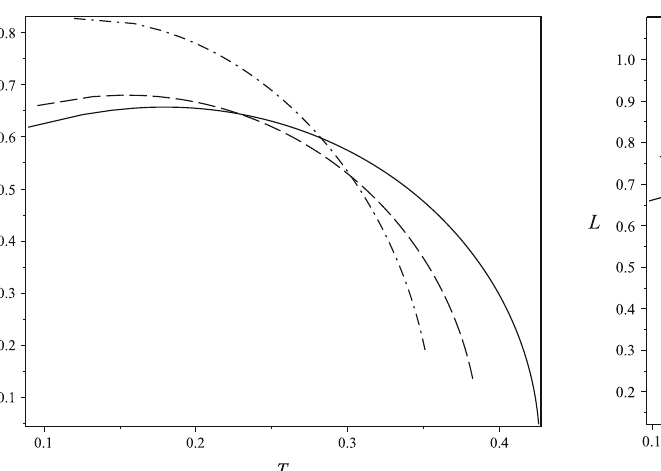
graph demonstrates the L – T dependence for fixed α = 0 . 3 and several values of n , namely n = 3 (dashed curve), n = 4 (dash-dotted curve), n = 6 (solid